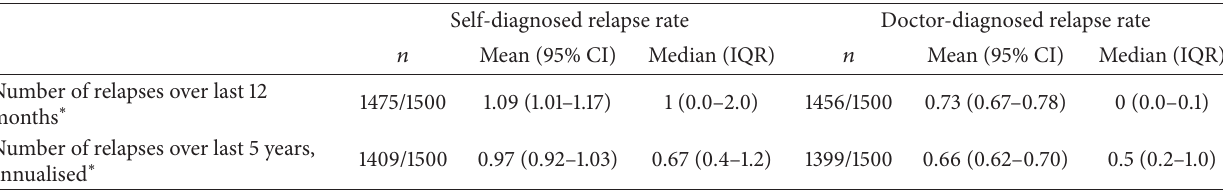
Table 6: Relapse rate for relapsing-remitting participants.